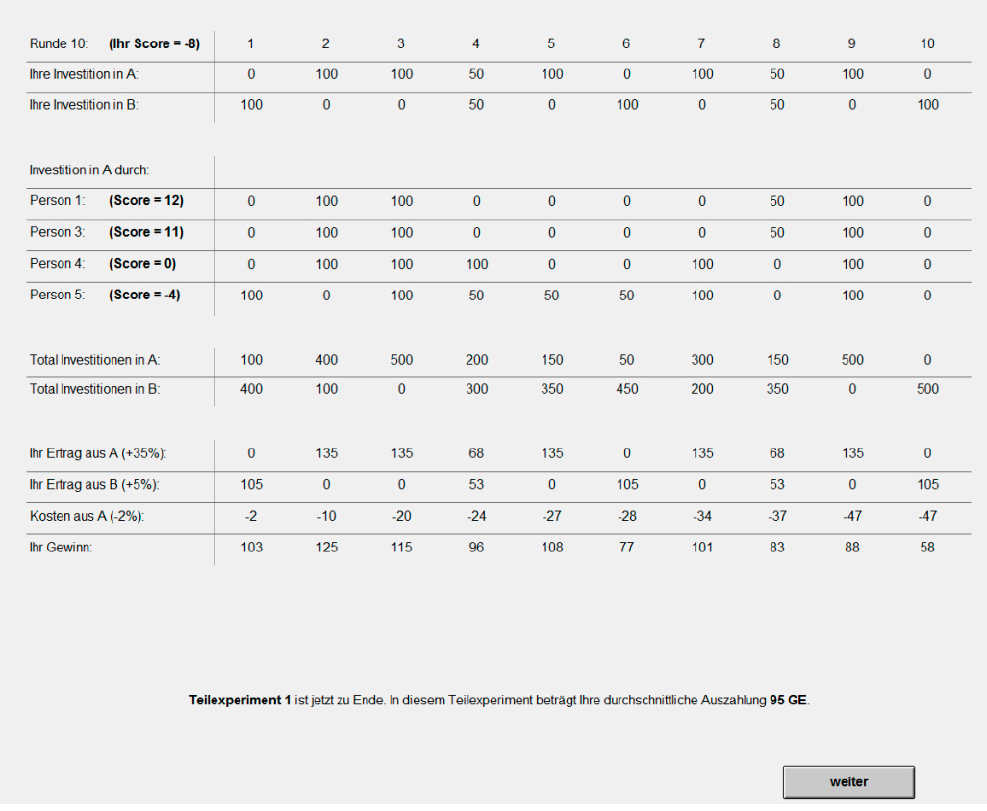
Figure A3. Final screen of Person 2 in public feedback condition.